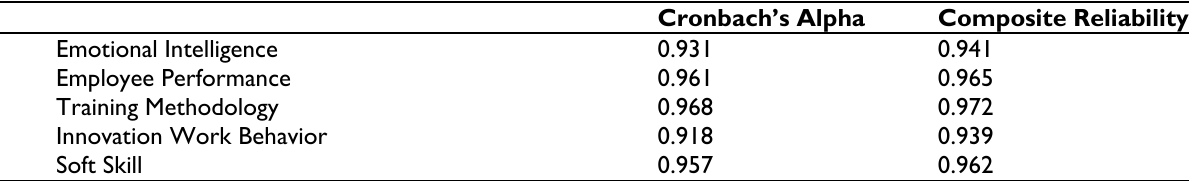
Table 2. Research variable construct reliability